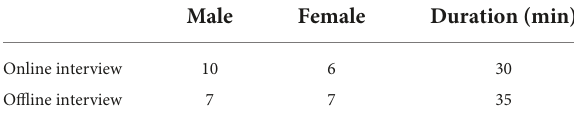
TABLE 1 Interview